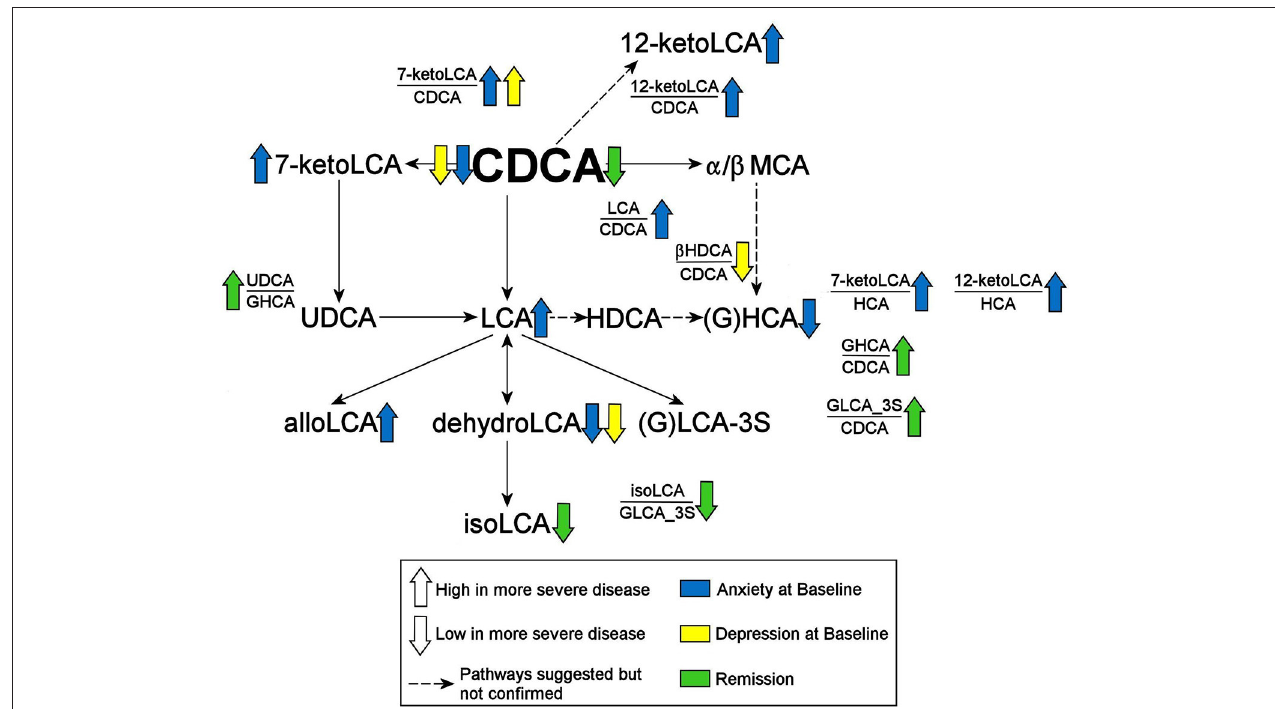
FIGURE 6 | Summary of findings. CDCA, Chenodeoxycholic Acid; GHCA, Glycohyocholic Acid; GLCA, Glycolithocholic Acid; HCA, Hydroxycitric Acid; HDCA, Hyodeoxycholic Acid; LCA, Lithocholic Acid; MCA, Monocarboxylic Acid; UDCA, Ursodeoxycholic Acid; _3S, 3 Sulfate.